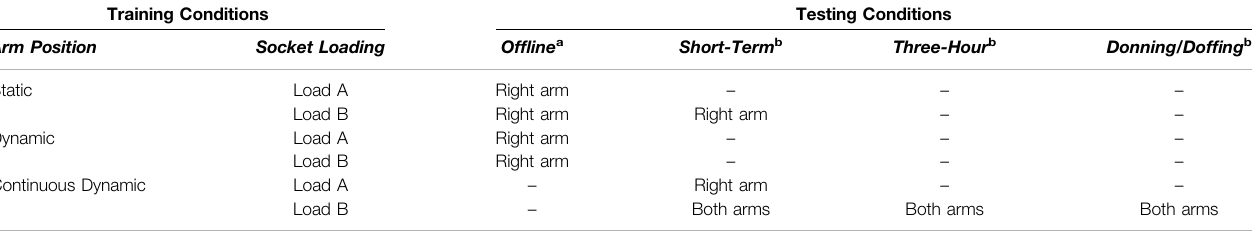
TABLE 1 | All training and testing conditions implemented in this study. Results from of fl ine testing were used to select a subset of training conditions for functional testing. Training Conditions